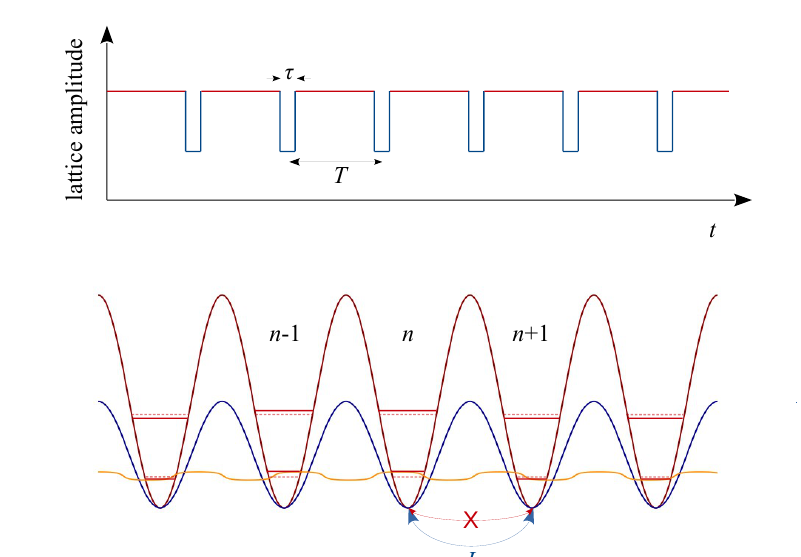
Figure 9: Ultracold-atom scheme to realize the proposed model. Lower panel: The atoms are trapped in a deep optical lattice (red line) with lattice sites labelled by n ∈ (cid:78) and vanishingly small hopping amplitude. The atoms occupy the correspond- ing Wannier fuctions, with a uniform on-site energy (lower dotted red bars) An addi- tional weak optical potential (orange line) modulates on on-site energies (solid red bars) according to Eq. (48). The primary lattice is periodically kicked every time T to a smaller amplitude (solid blue line) for a short time τ , hence setting up a finite hopping energy J . Upper panel: Time sequence of the lattice amplitude with color scheme consistent with the lower